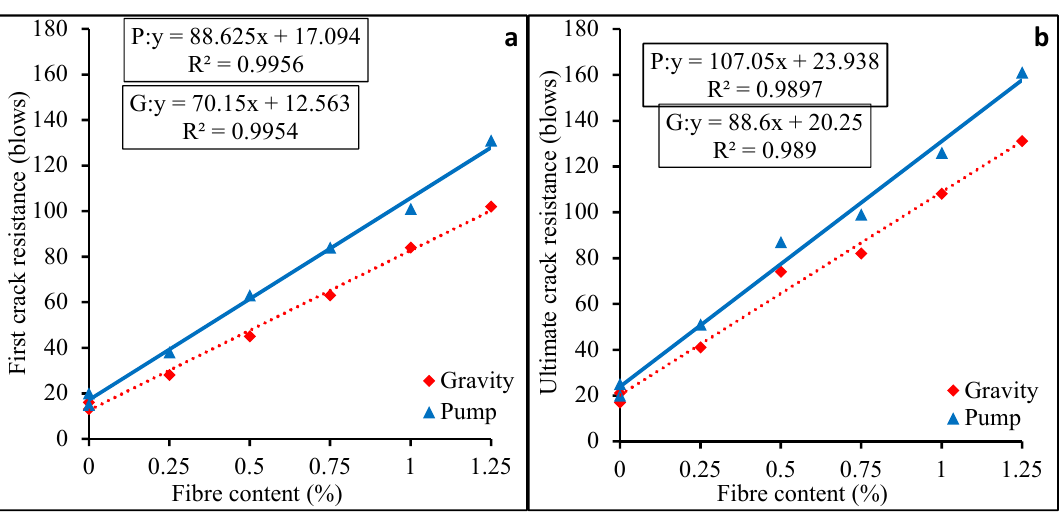
Figure 15. Impact resistance at ( a ) first and ( b ) ultimate crack vs. fibre content of PAFRC specimens.